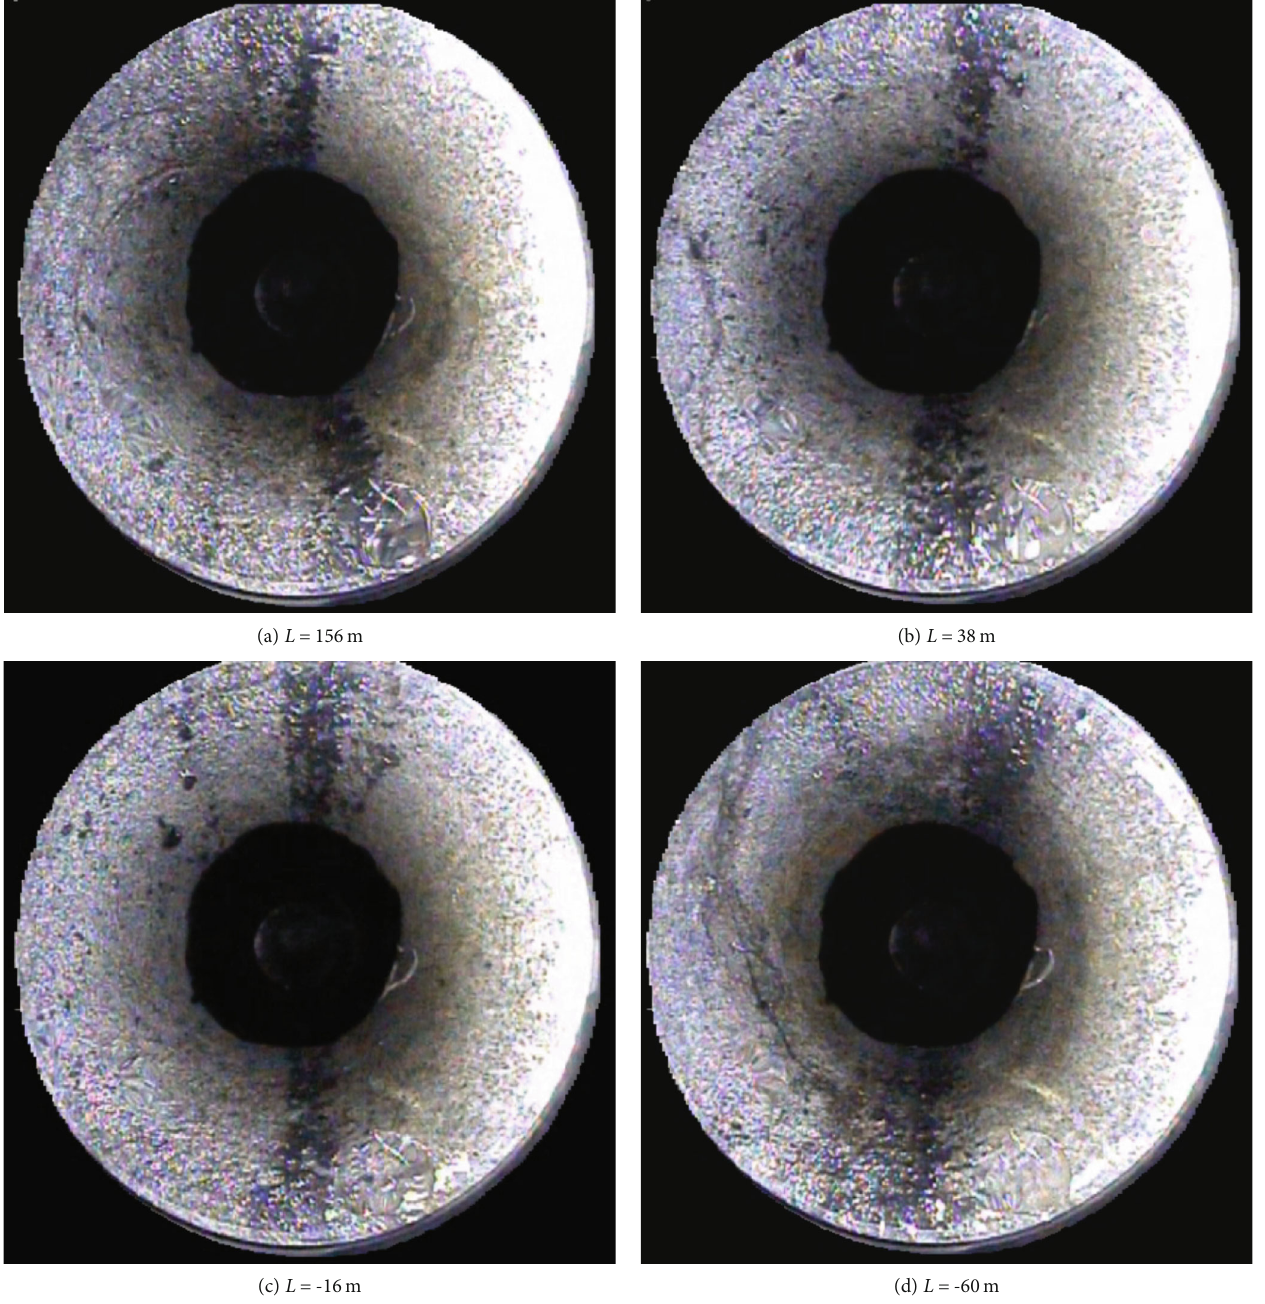
Figure 9: Image of damage and deformation at the vertical depth of